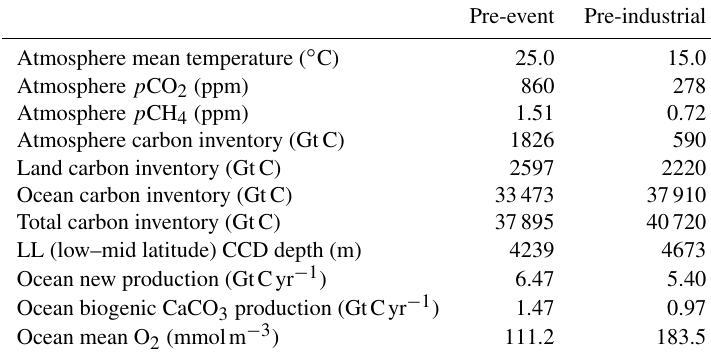
Table 1. Pre-event steady-state solution properties compared to pre-industrial properties. CCD is the calcite compensation depth.